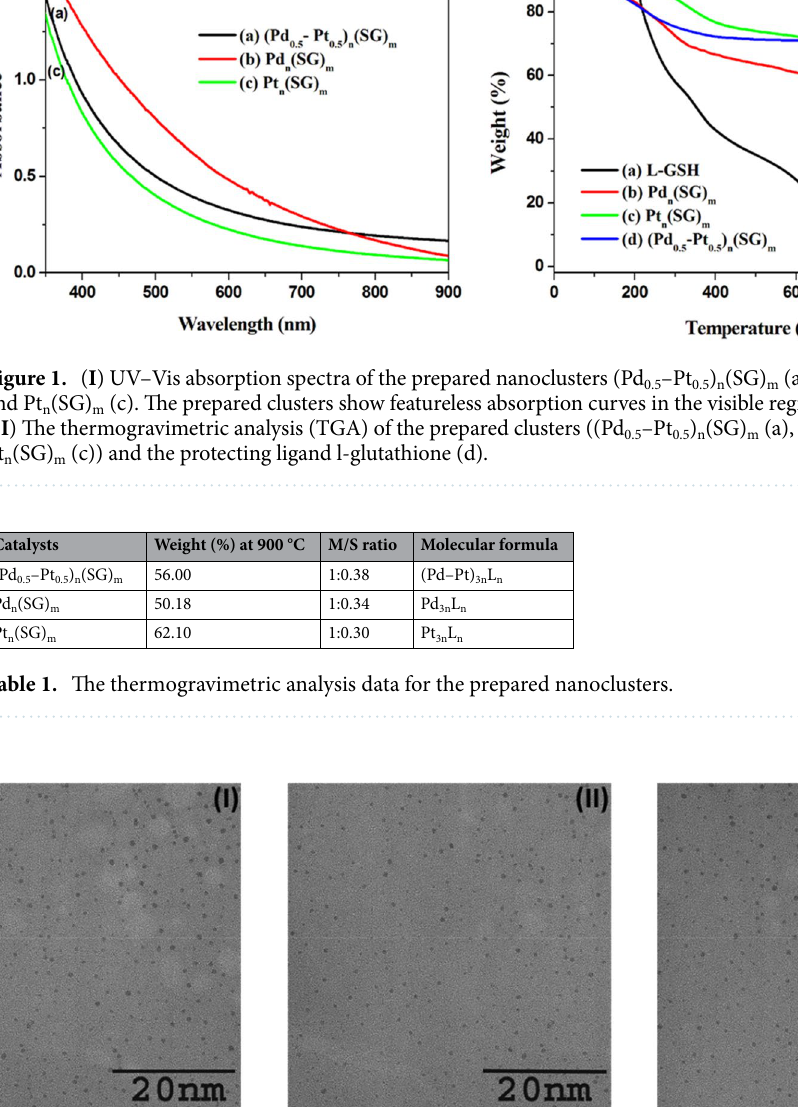
Figure 2. High resolution-transmission electron microscopy (HR-TEM) images of the prepared clusters